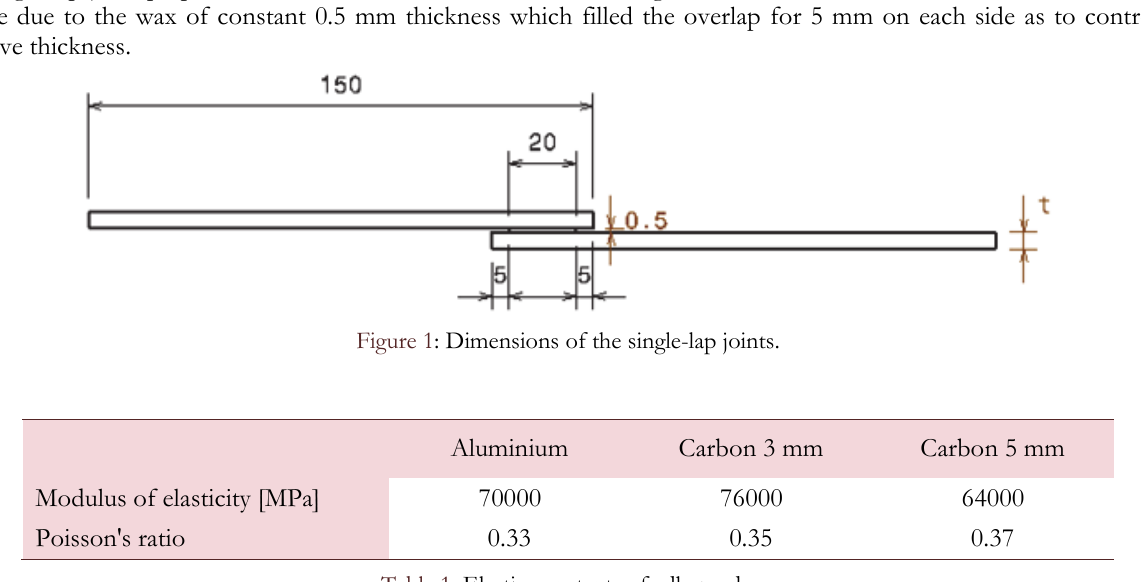
Table 1: Elastic constants of adherends.